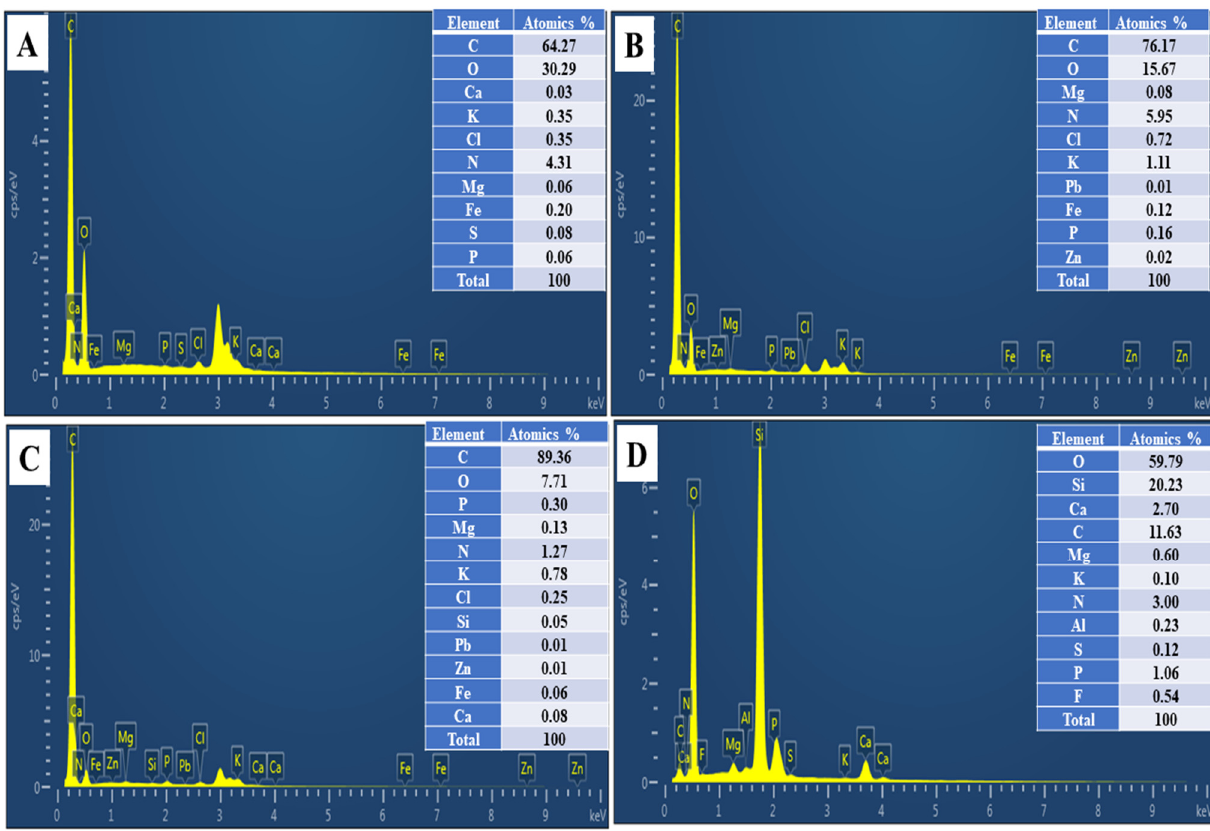
Figure 3. EDS analysis of corn cob (CC) ( A ); corn cob-derived biochar produced at 400 °C (CB400) ( B ), corn cob-derived biochar made at 600 °C (CB600) ( C ), apatite ore ( D ).